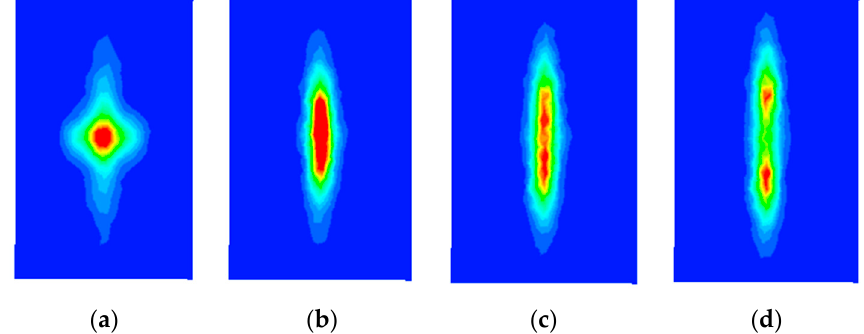
Figure 11. Coating film thickness contours when L = 20 mm: ( a ) θ = 0°; ( b ) θ = 5°; ( c ) θ = 10°; ( d ) θ = 15°.